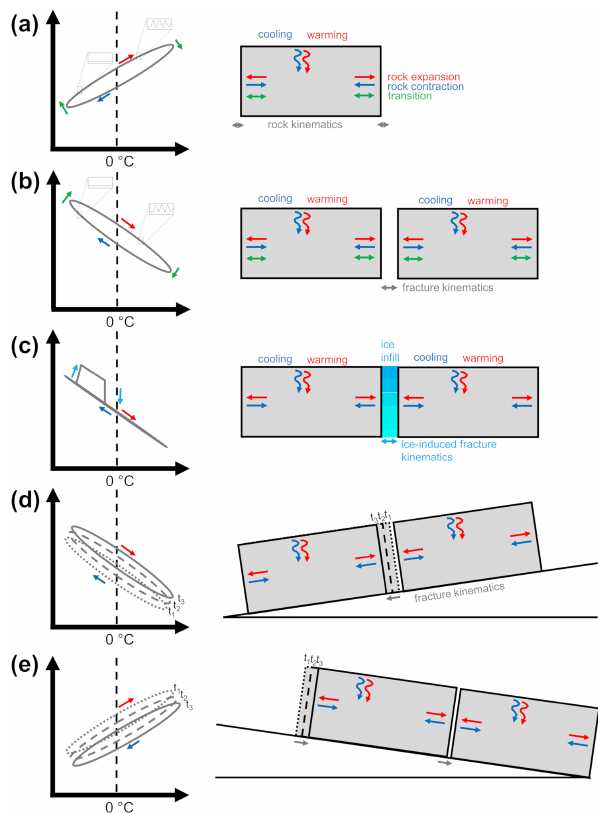
Figure 10. Conceptual illustration of (a) thermally induced rock kinematics, (b) thermally induced fracture kinematics, (c) ice- induced fracture kinematics, (d) thermally induced rock creeping on a shear plane dipping out of the rockwall and (e) thermally in- duced rock kinematics on a shear plane dipping into the slope. Insets in (a) and (b) show daily temperature oscillation below snow cover and without snow